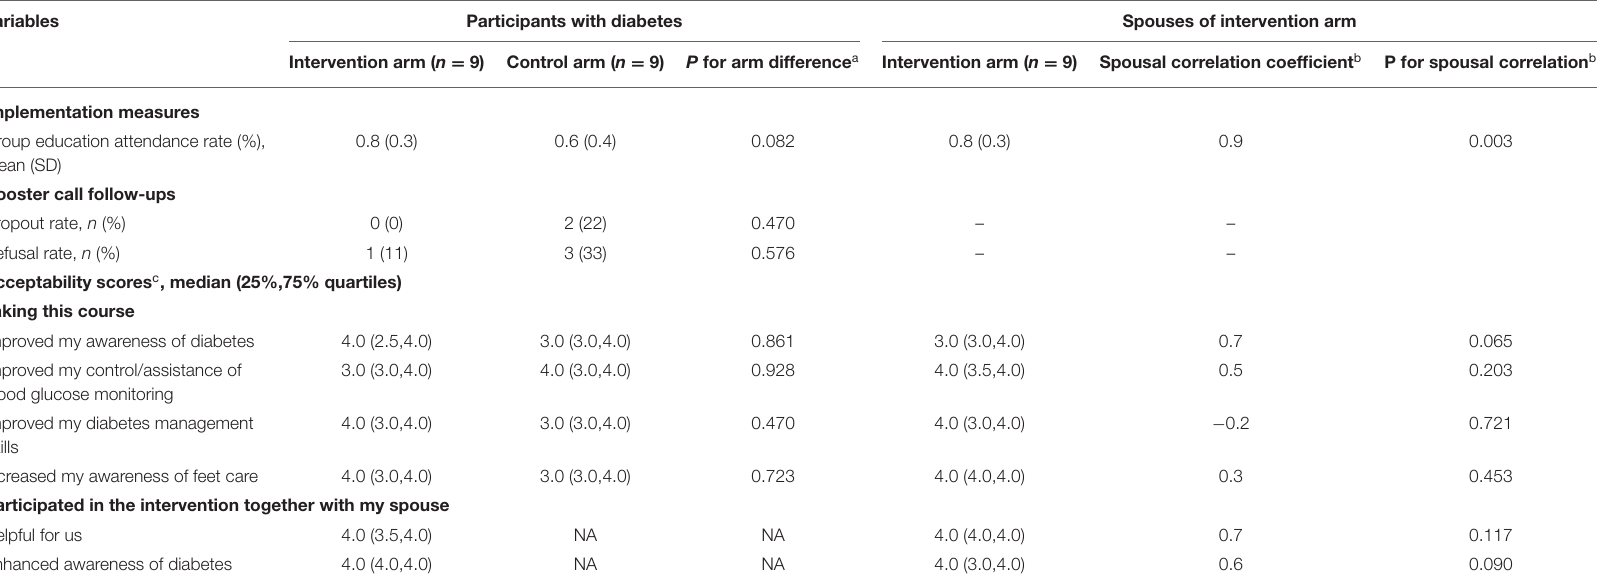
TABLE 4 | Implementation assessments of the 3-month pilot study (couple pair N = 18). Variables Participants with diabetes Spouses of intervention